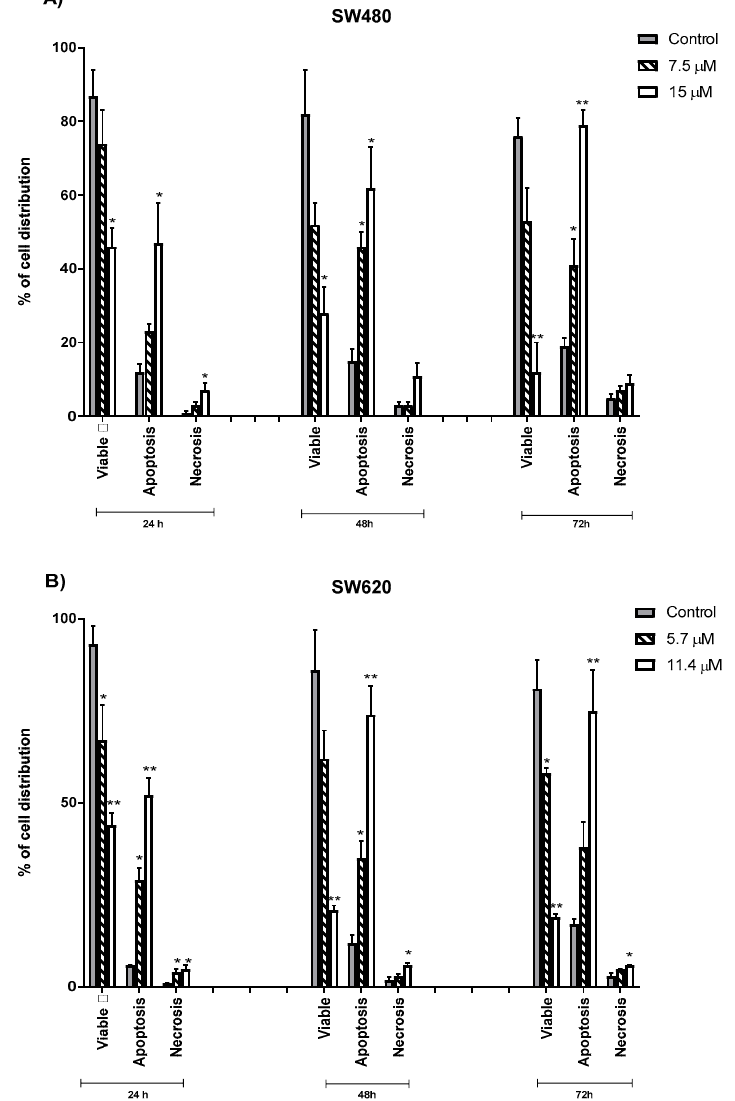
Figure 6. Percentage of viable, apoptotic, and necrotic cells in SW480 ( A ) and SW620 ( B ) treated with MS13 for 24, 48, and 72 h. Treated and non-treated cells were double-stained with Annexin V / Propidium Iodide and a minimum of 200 cells were counted per sample. Experiments were performed in triplicates and results were compared between two independent experiments. Comparison between data sets was performed using ANOVA. Asterisk indicates statistically significant (* for p ≤ 0.05, ** for p ≤ 0.01, *** for p ≤ 0.001 and **** for p ≤ 0.0001) differences between the means of values with treated vs untreated cells. Error bars indicate mean ± SEM.